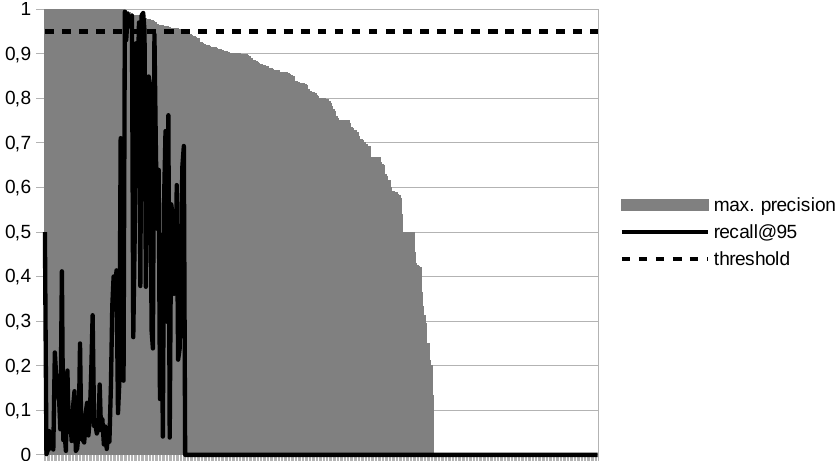
Figure 3. Depiction of precision and recall@95 for the models created, ordered by precision.